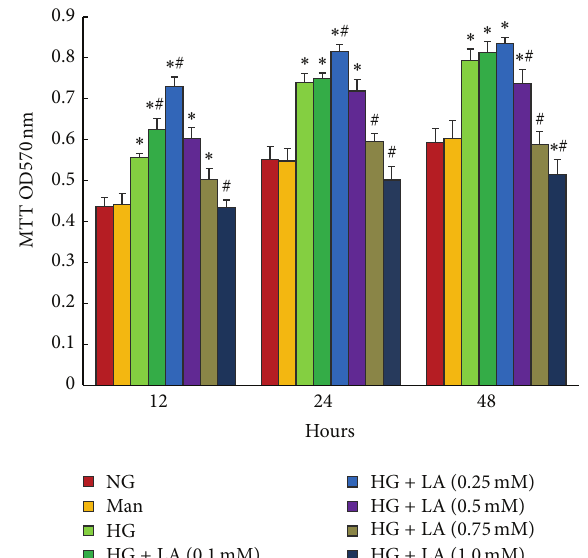
Figure 1: LA dose-dependently regulated high glucose-induced proliferation of rat mesangial cells. Proliferation of mesangial cells was determined by MTT assay. LA accelerated mesangial cell proliferation induced by high glucose for 12, 24, or 48 h, at final concentrations of 0.1, 0.25 mmol/L, respectively, while cell proliferation caused by high glucose was inhibited as the dose of LA increased to > 0.5mmol/L. Values are given as mean ± SD ( 𝑛 = 6 ) and 𝑃 < 0.05 was considered statistically significant. Note: ∗ 𝑃 < 0.05 versus NG; # 𝑃 < 0.05 versus HG. Abbreviations: NG, normal glucose (5 mM); Man (5mM glucose + 2 5 mM mannitol); HG, high glucose (30